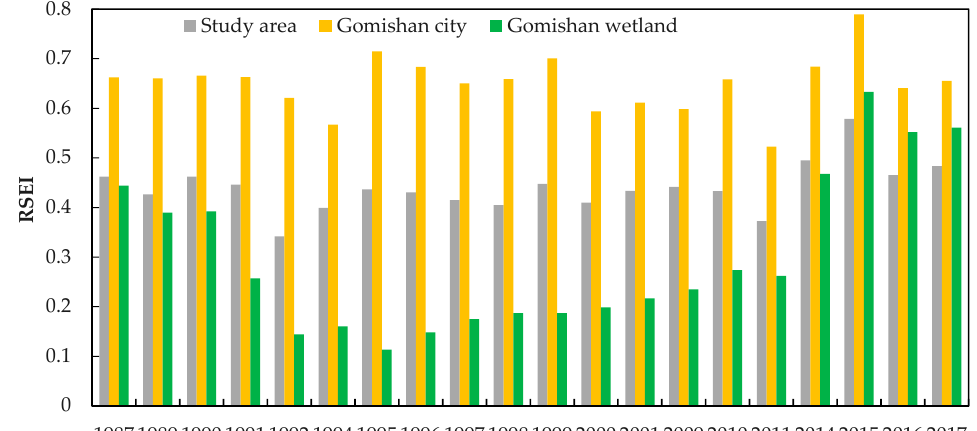
Figure 13. The RSEI mean for the study area, Gomishan wetland, and the Gomishan city.